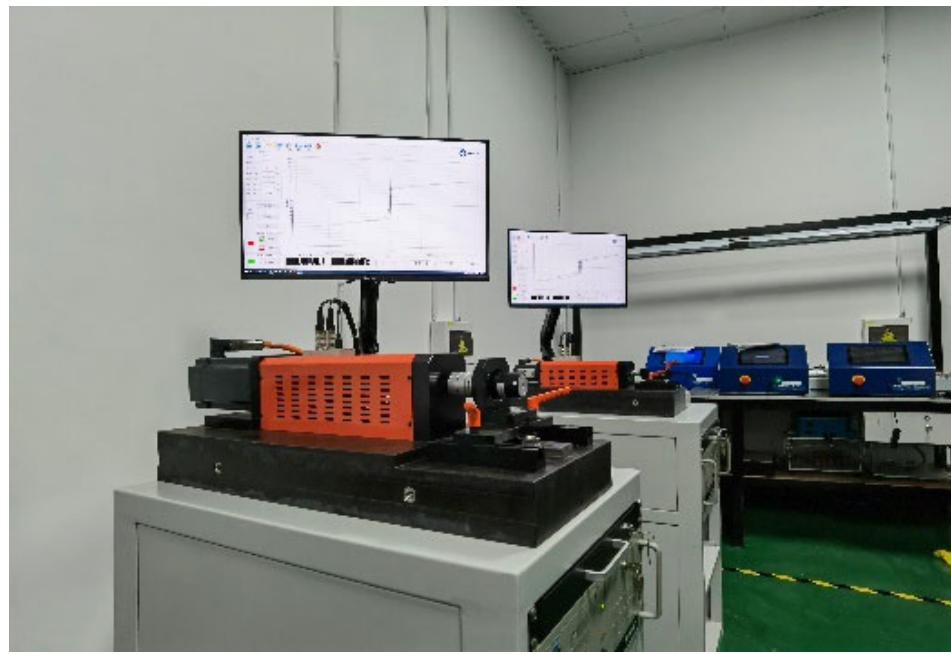
and 𝛿 . (cid:3034) (cid:3032)